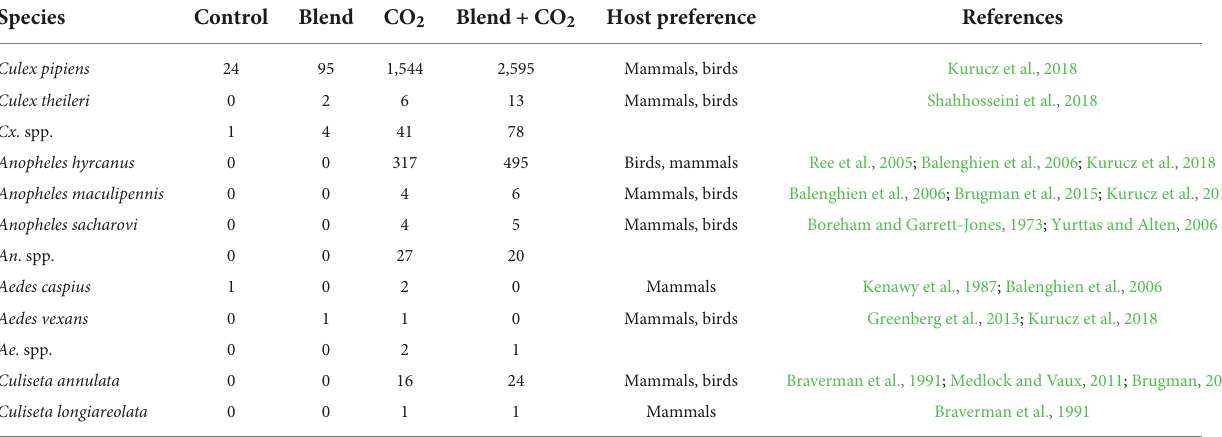
TABLE 1 Species and number of mosquitoes caught in Sindos, Thessaloniki (Greece) using odor-baited Encephalitis Vector Survey mosquito traps. Species